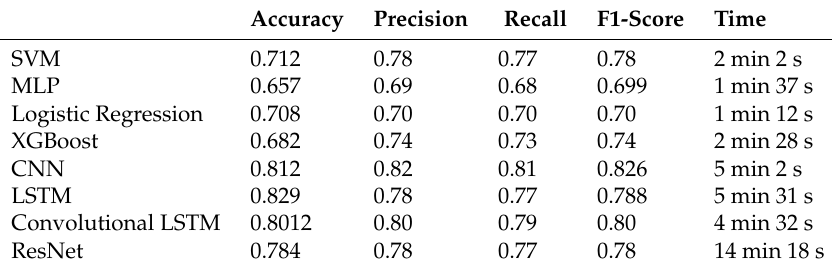
Table 6. Summary of Results—MIT-BIH Atrial Fibrillation.